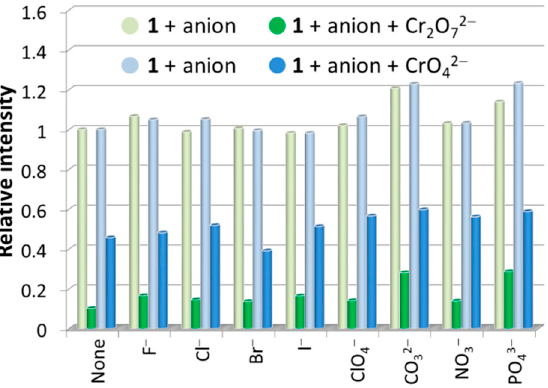
Figure 8. Fluorescence relative ratio responses of 1 in H 2 O suspensions containing various anions before and after addition of Cr 2 O 72 − /CrO 42 − ions with equal concentrations at 1.0 mM.